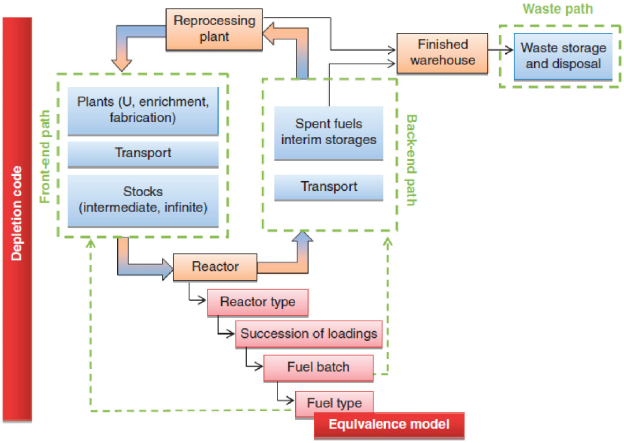
Fig. 2. COSI6 operating diagram. Table 1. Main characteristics of the reactors featured in the